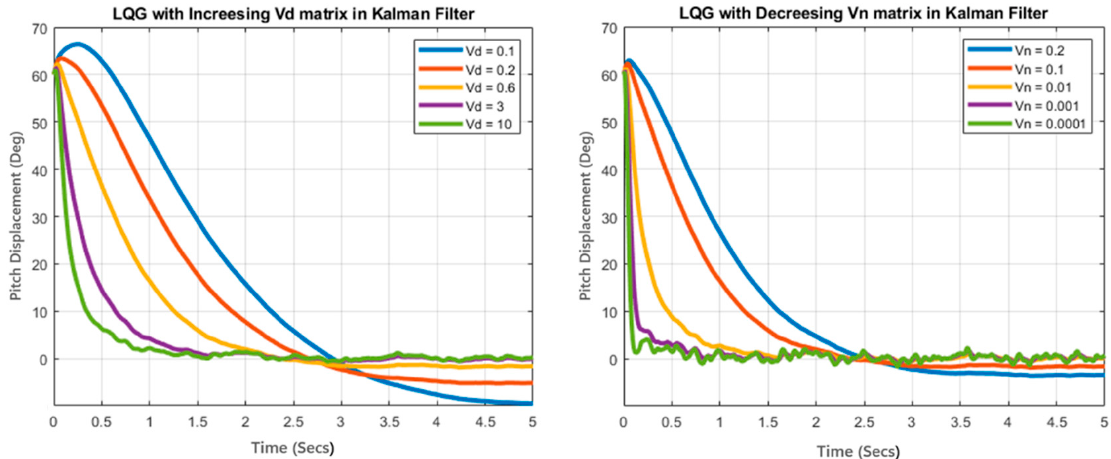
Figure 9. Comparison of varying Vd and Vn matrix values.